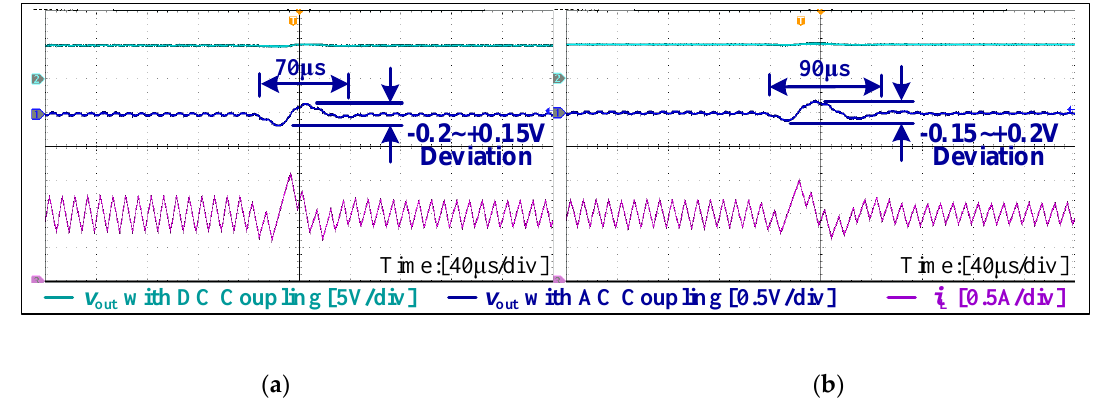
Figure 23. Output voltage transients under DPVP control when v in steps from 12 to 9.5 V: ( a ) L a = 1.3 L and ( b ) L a = 1.6 L.